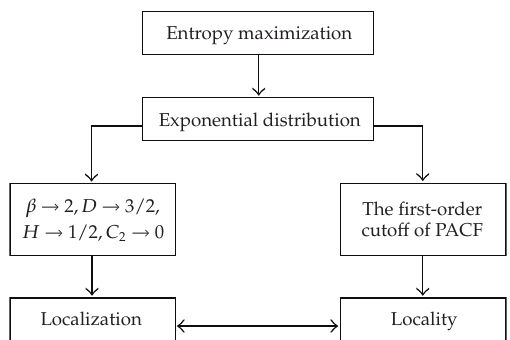
Figure 5: Entropy maximization suggesting localization of urban population